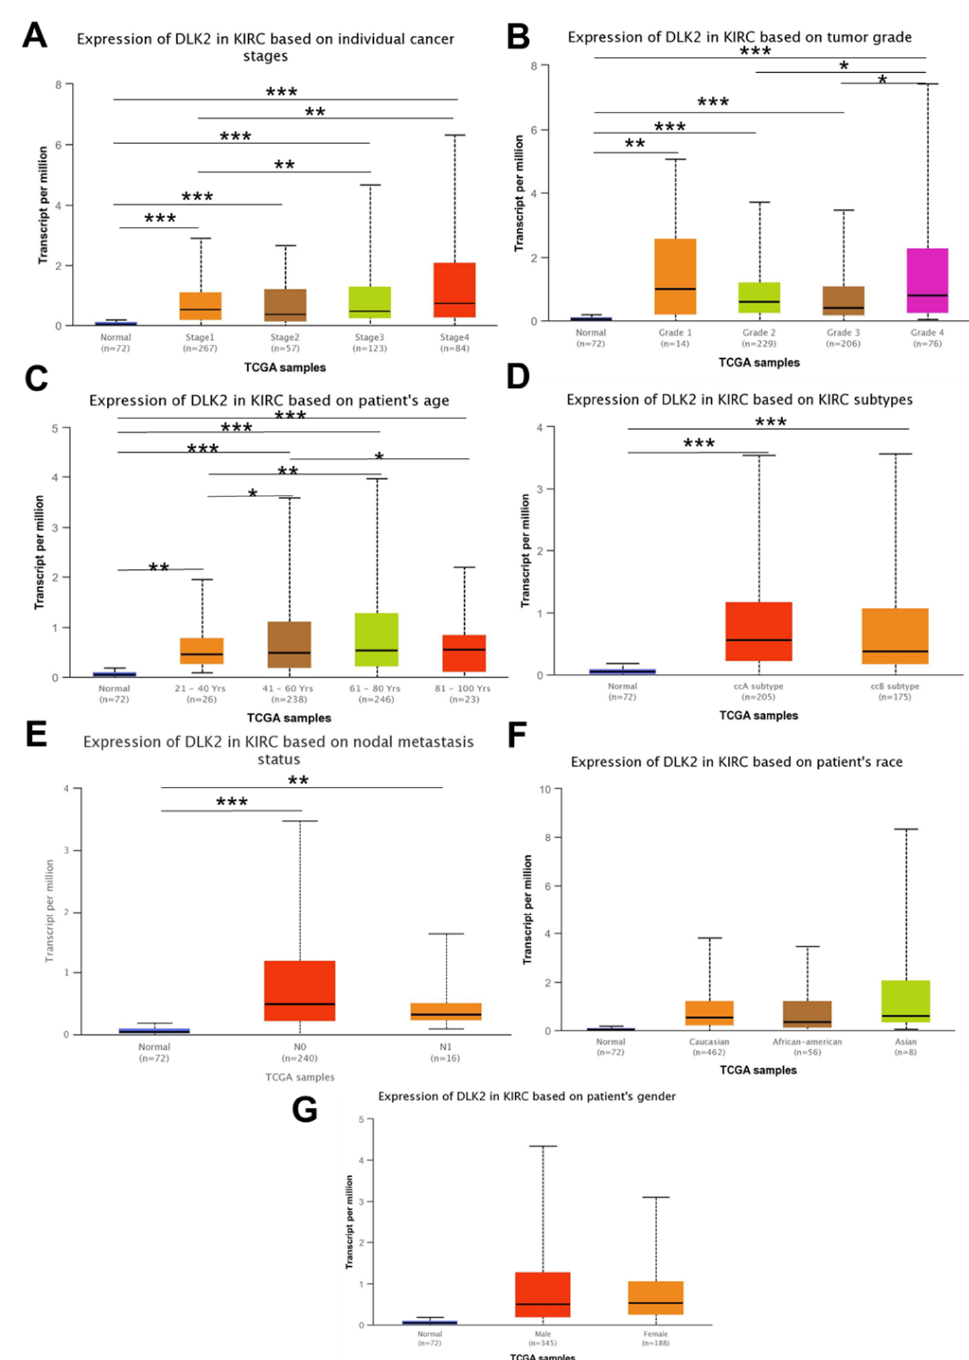
Figure 3. Tumoral DLK2 overexpression is associated with advanced stage and high grade in ccRCC patients. The UALCAN analysis for the tumoral DLK2 level in ccRCC patients with different ( A ) stages, ( B ) grades, ( C ) ages, ( D ) cancer subtypes, ( E ) metastasis status, ( F ) races, and ( G ) genders. * p < 0.05; ** p < 0.01; *** p < 0.0001.